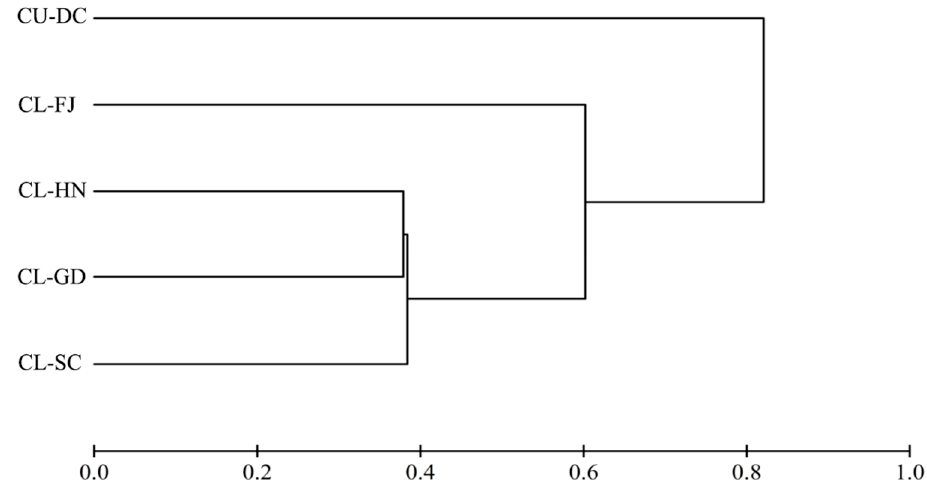
Figure 5. System clustering of drought tolerance of C. unica and C. lanceolata .